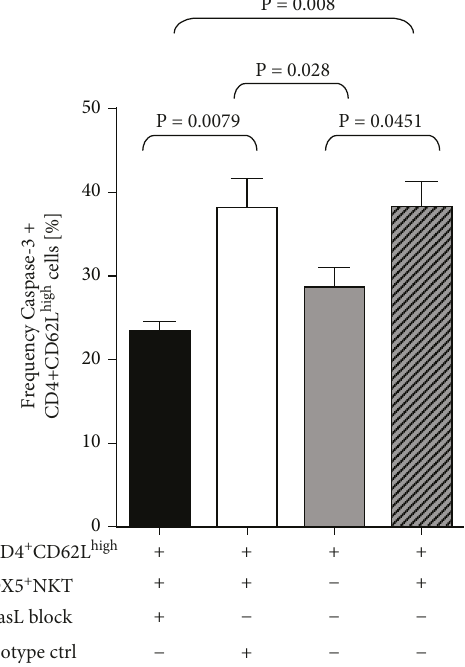
Figure 5: Intracellular fl ow cytometry analysis of caspase-3 in CD4 + CD62L high cells after 48 h of coculture with CD3 + DX5 + NKT cells and pretreatment with either FasL block or isotype control. Results are given as mean+ SEM. Experiments were repeated at least three times ( ∗ P < 0 05